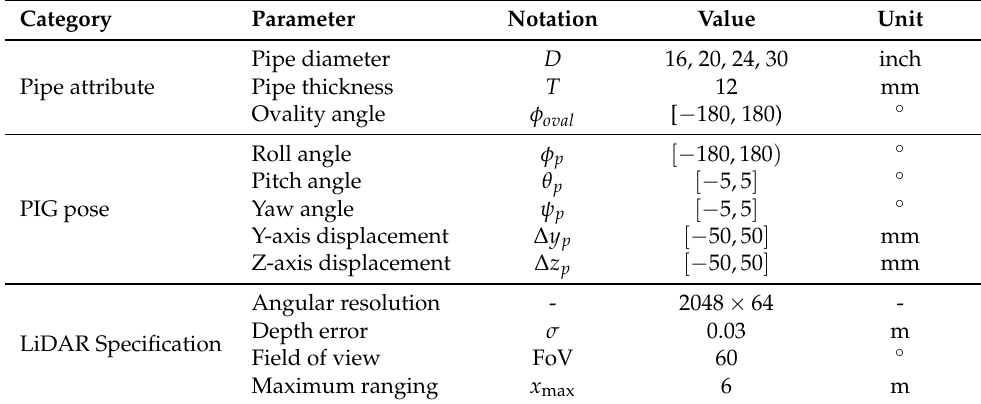
Table 1. Simulation